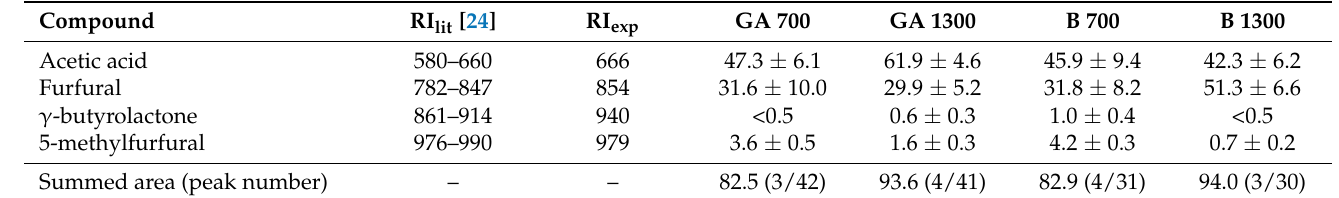
Table 4. The most abundant identified VOCs and their relative area % from the total peaks in SPME-GC-MS chromatograms of the woody biomass binder-less boards.